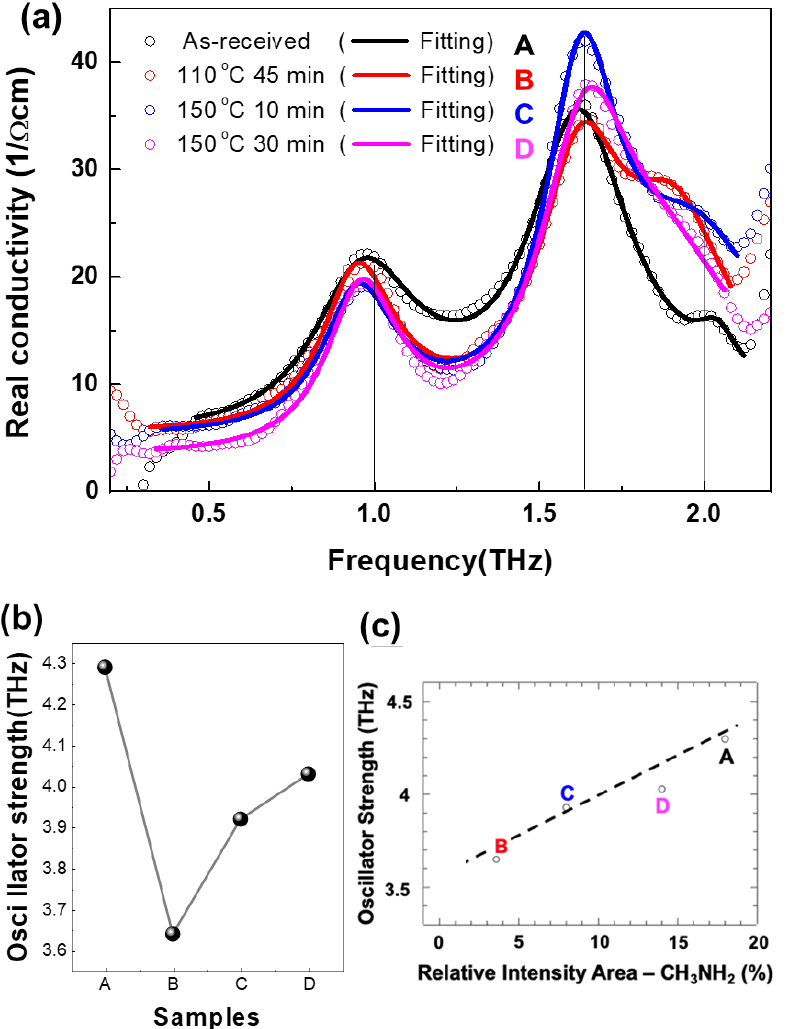
Figure 5. ( a ) THz real conductivities of A, B, C, and D. The Lorentz oscillator model fitting results are plotted by line. ( b ) The fitting results of oscillator strength of the 1.6 THz resonance peak. ( c ) The correlation between ( b ) and the relative intensity area for the chemical state of the CH 3 NH 2 molecular defect (Figure 3b).